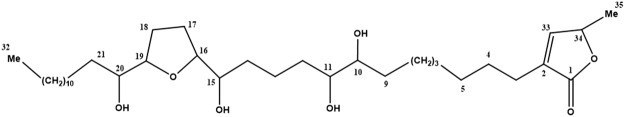
Chemical structure of annomuricin E.